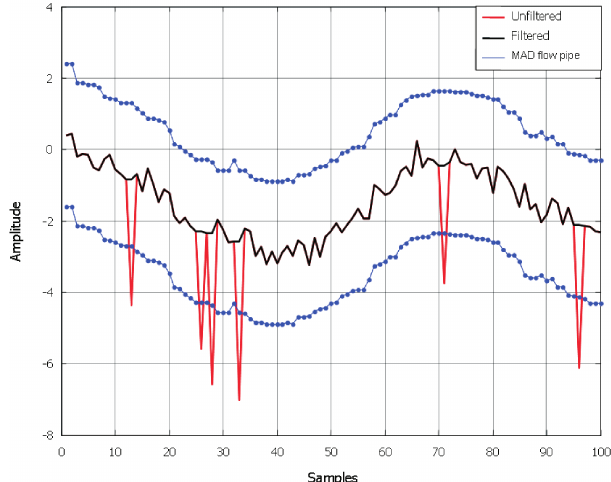
Figure 3. Application of the wavelet based algorithm applied to the mining